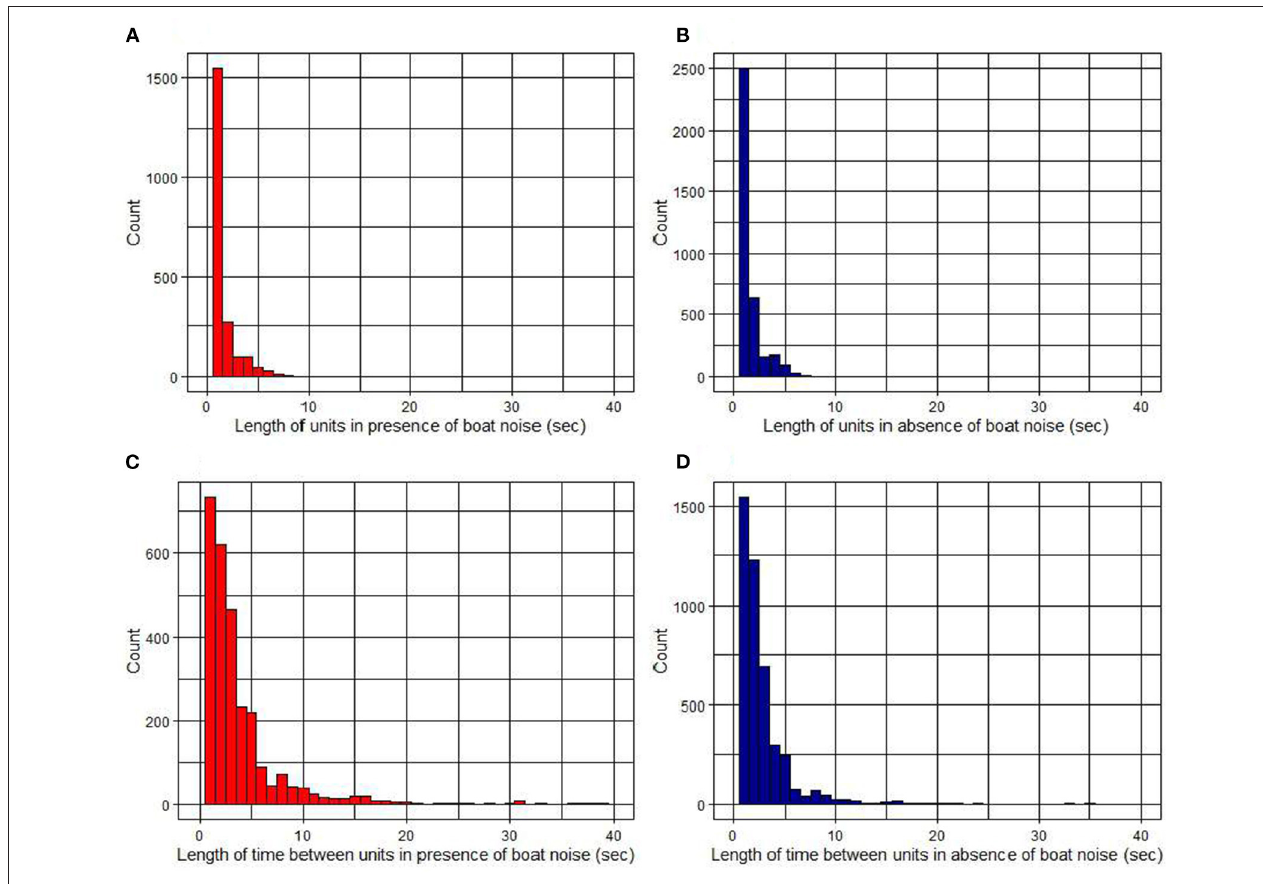
FIGURE 7 | Temporal difference in units and unit spacing in the presence and absence of boat noise: (A) length of song units in presence of boat noise and (B) absence of boat noise (C) ; length of IUIs in the presence of boat noise and (D) absence of boat